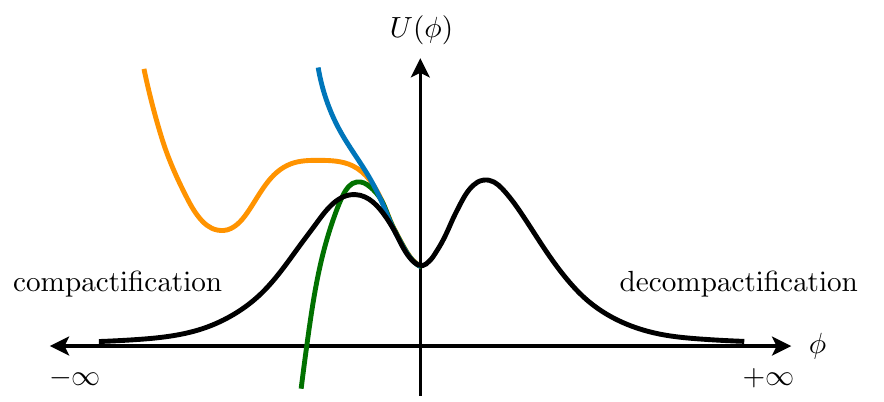
Figure 1 . Theories featuring compactified extra dimensions, and moduli spaces that are stabilized at a positive value of the vacuum energy, are typically susceptible to decay into a higher-dimensional, decompactified theory, [26–28], as indicated by the φ ≥ 0 region in this figure. On the other hand, the behavior of the scalar potential in the compactification limit may vary widely depending on the details of the higher-dimensional construction. Our work will be concerned with instabilities of four-dimensional de Sitter vacua into the compactification regime, where φ ≤ 0 . The location of the de Sitter false vacuum is arbitrary, and we choose φ 0 for fv ≡